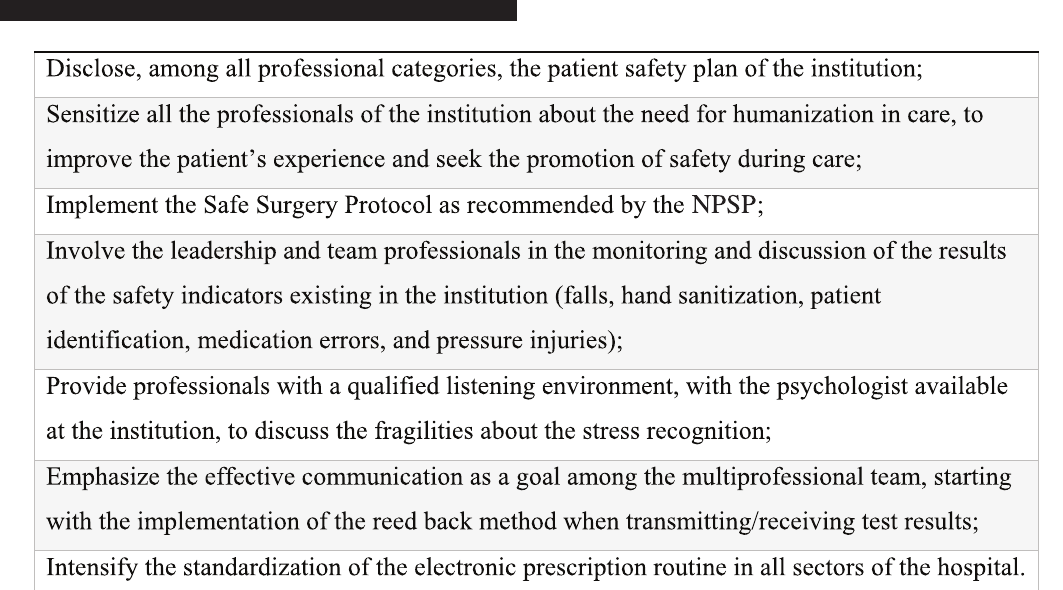
Figure 1. Priority actions listed by the